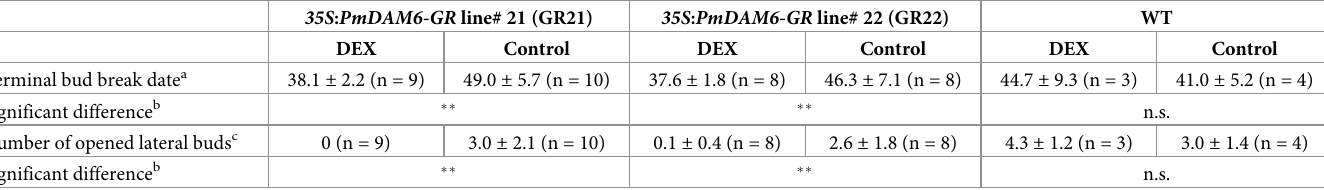
Table 1. Accelerated terminal bud break and inhibition of lateral bud break in 3-year-old 35S : PmDAM6 and 35S : PmDAM6-GR apple plants treated with DEX. 35S : PmDAM6-GR line# 21